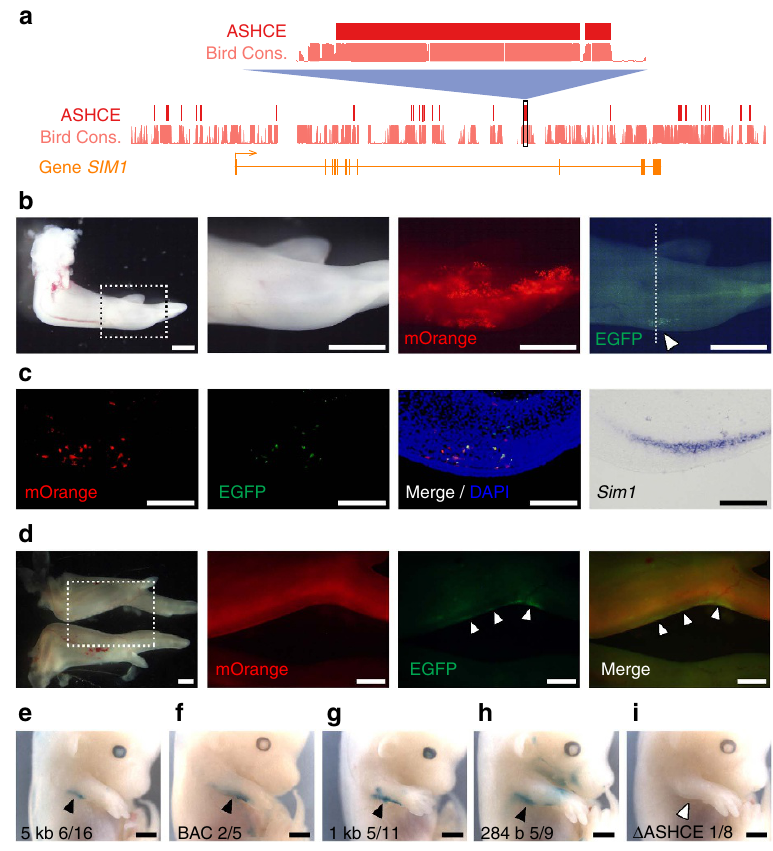
Figure 5 | A Sim1 -associated ASHCE represents an enhancer activity. ( a ) Schematic representation of gene structure of Sim1 , as well as base-wise conservation scores for ASHCEs. The region harbouring the highest scoring ASHCE associated with Sim1 is zoomed in. ( b ) Whole-mount images of the forelimb bud six days after electorporation. Ventral views of the right forelimb bud are shown (the original image was flip-flopped horizontally). Dotted box indicates magnified area. The reporter EGFP signals were observed in the posterior edge (white arrowhead) inside broad mOrange signals co-transfected. ( c ) Transverse section on the plane of dotted line in b . The signals were detected by immunostaining for EGFP and mOrange proteins. Expression of Sim1 mRNA on the adjacent section is also shown. Note that the reporter signal was restricted inside/around the endogenous expression domain of Sim1 . ( d ) Whole-mount images of a specimen 7 days after injection of virus-infected cells. The forelimbs on the top and bottom are the virus-infected and uninfected (contralateral) ones, respectively. Dotted box indicates magnified area, clearly showing that the reporter EGFP signals were detected in the posterior margin of the forelimb bud (white arrowheads). ( e – i ) Reporter expression pattern in transgenic mice. Lac Z reporter activities of transgenic embryos (E14.5) of Sim1 ASHCE 5kb ( e ), the chicken BAC clone (CH261-127C13) ( f ), Sim1 ASHCE 1kb ( g ), Sim1 ASHCE 284 b ( h ) and Sim1 D ASHCE ( i ) were shown. The ratio at the right bottom corner in each ( e – i ) indicates the number of the embryos with the LacZ signal in the posterior margin of the forelimb bud (embryos stained ubiquitously or broadly were excluded), to the number of Tg-positive embryos. Black and white arrowheads indicate obvious and no LacZ signal in the posterior margin of the forelimb, respectively. The reporter vectors used here are shown in Supplementary Fig. 9. Scale bars, 1mm ( b , d – i ); 100 m m ( c